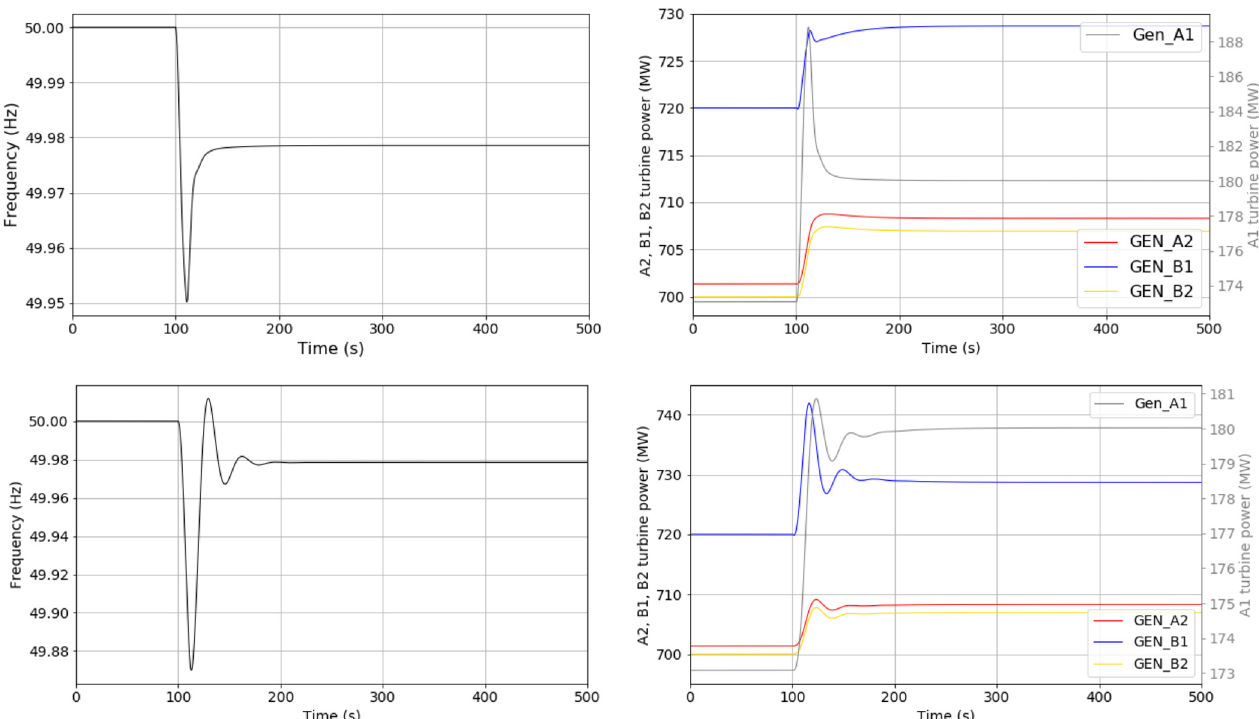
Fig. 8. Frequency response (left) and turbine powers (right) after a 30 MW RE power fall with thermal group (top) and without thermal group